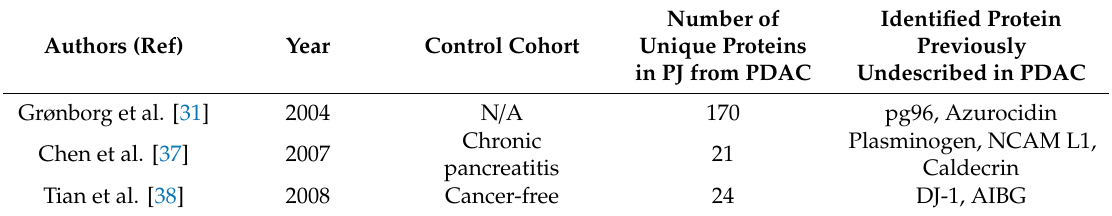
Table 1. Comprehensive proteomic analyses of pancreatic juice from PDAC